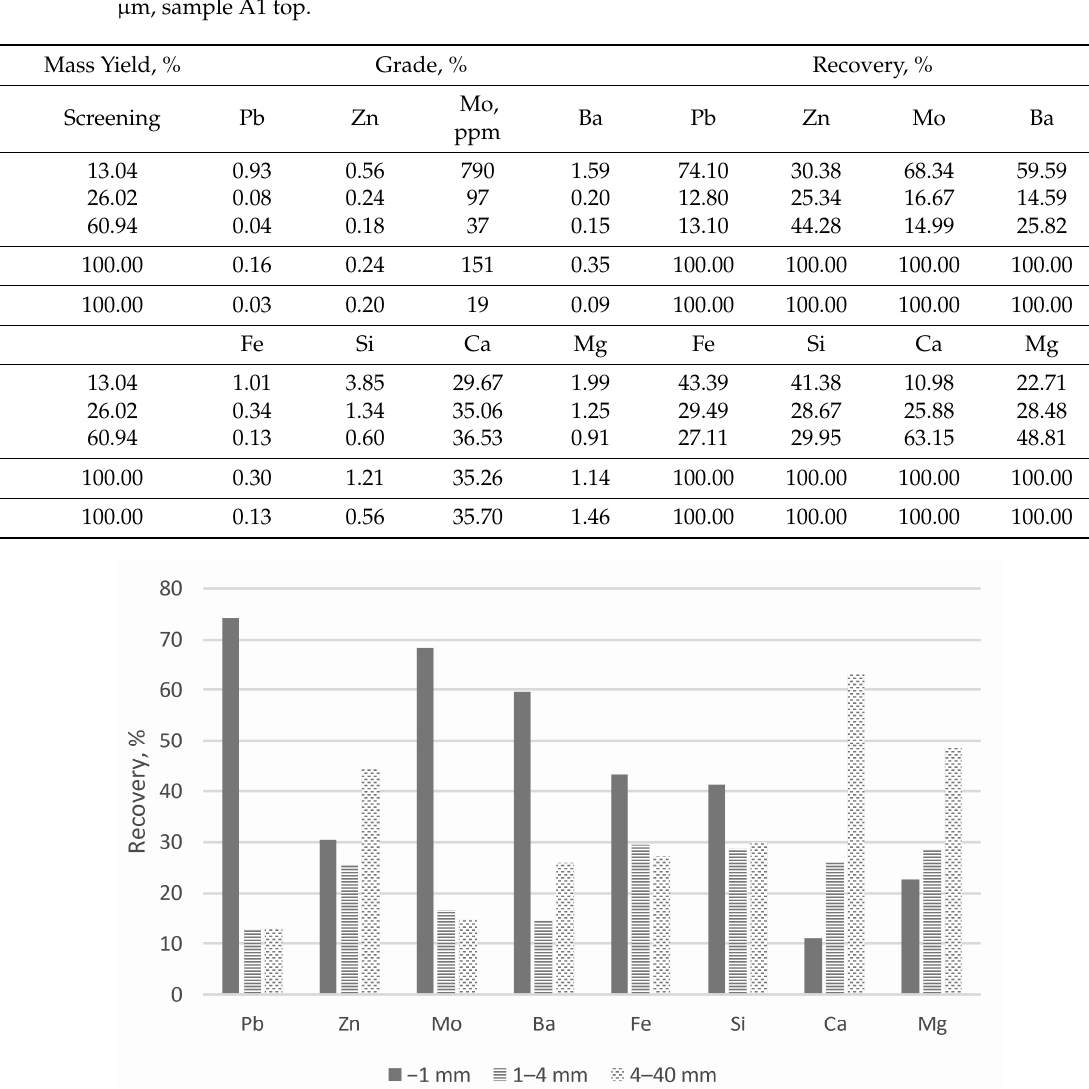
Table 8. Grades and distribution of selected components within the deslimed size fractions 30–1000 µ m, sample A1 top.